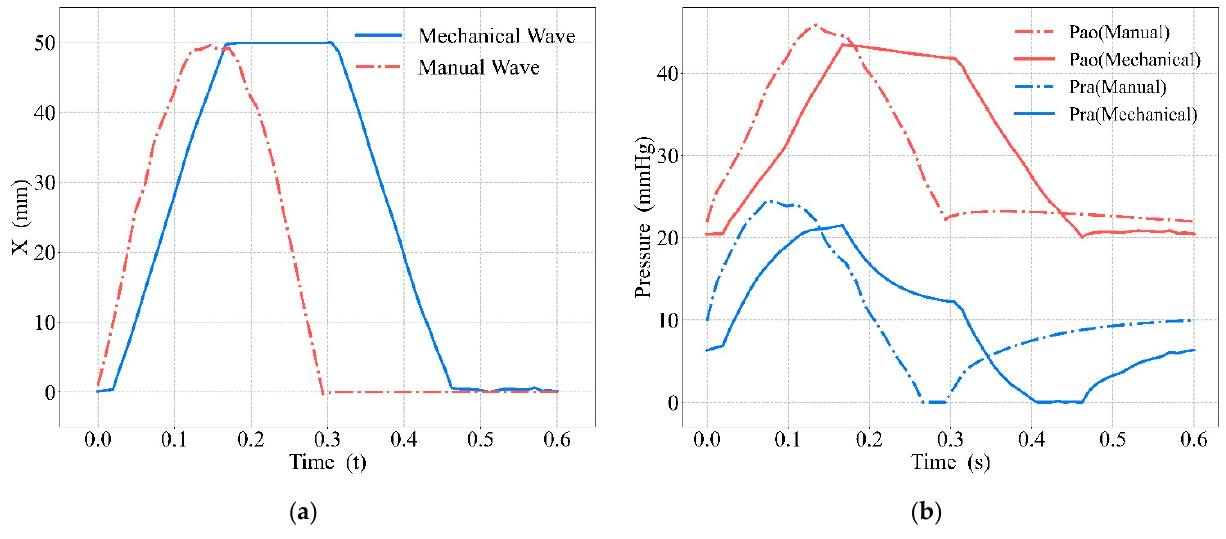
Figure 11. Comparison between mechanical and manual compressions: ( a ) compression waveform, ( b ) blood pressure. Table 3. Detailed blood pressure information with mechanical and manual waveforms.